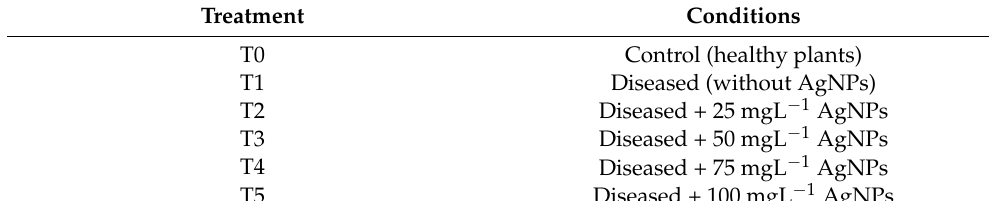
15 of 23 Figure 10. Methodology of green synthesis of silver nanoparticles.